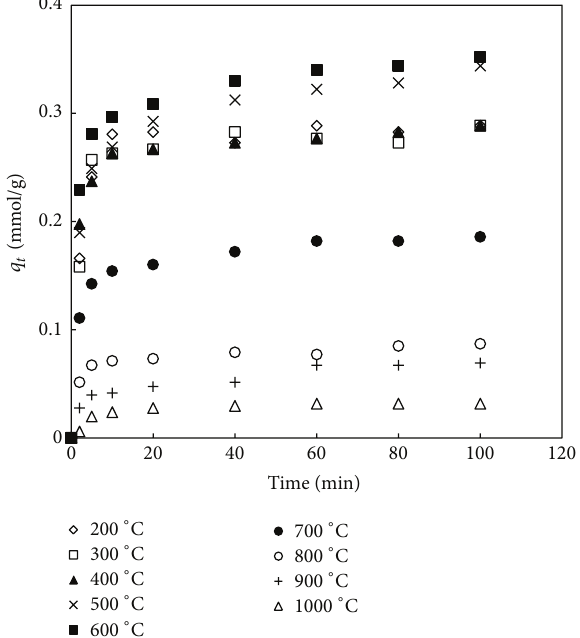
Figure 6: Kinetic dependencies for the sorption of AO7 on CeO 2 annealed at different